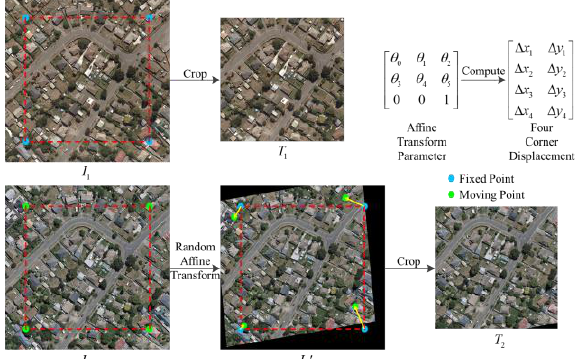
Figure 5. An example for generation of an image